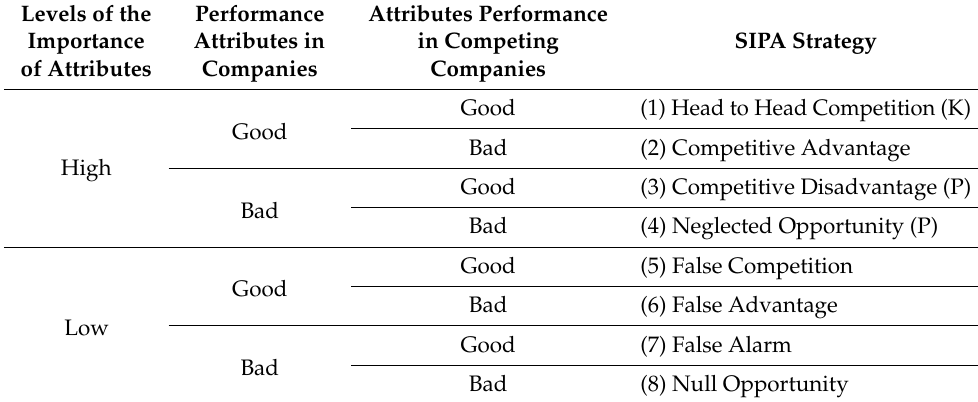
Table 1. Classification of SIPA Strategies and IPA